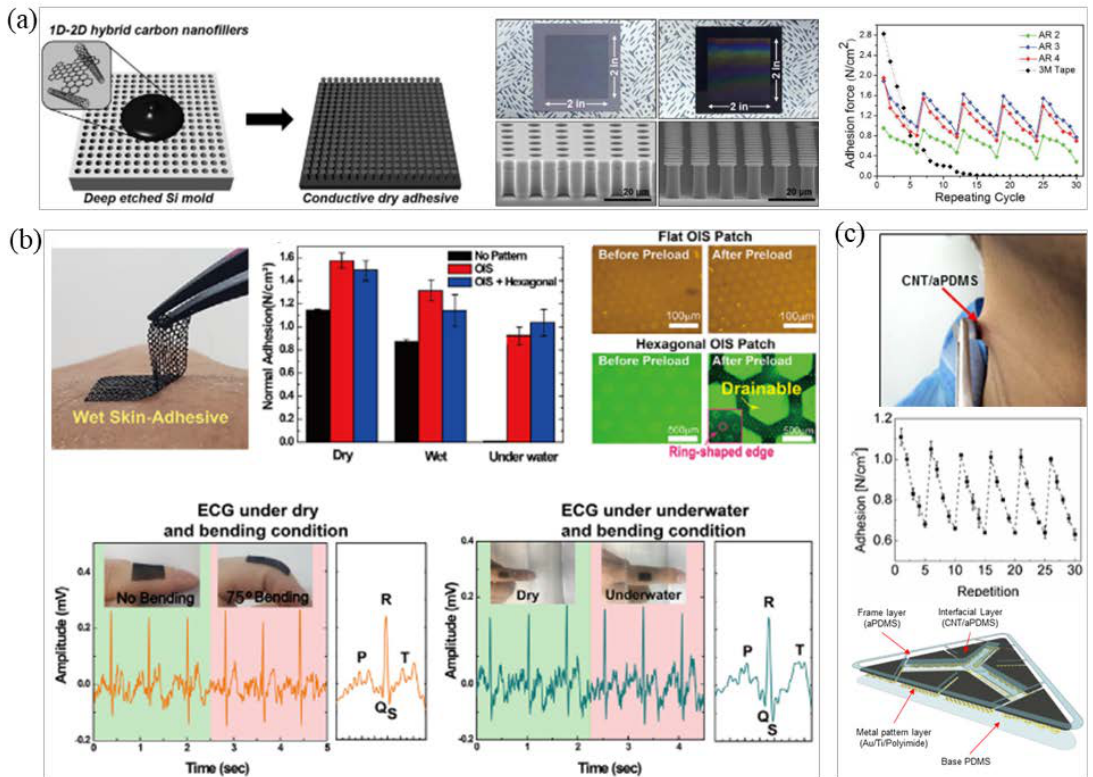
Figure 5. A summary of preparation strategies for high-adhesive electrical physiology electrodes based on bionic microstructures and conductive adhesives. ( a ) Schematic illustration of the fabrication procedure for conductive dry adhesives; digital images of a large-area silicon mold with gecko-inspired micropatterns and a replicated conductive dry adhesive; cyclic adhesion property of conductive dry adhesives compared to a commercial 3 M wet adhesive. Reproduced with permission from [119]. Copyright 2016, American Chemical Society. ( b ) Optical image of a hexagonal mesh-patterned conductive polymer composite (CPC) film with an OIS attached to human skin; normal adhesion strength for flat, OIS, and hexagonal mesh-patterned films with an OIS in dry, wet, and underwater conditions on a skin replica with a preload of 1.0 N cm − 2 ; fluorescence microscopic images representing conformal contact of a HMP OIS patch underwater; biosignals (ECG) detected by CPC stretchable electrodes attached to a human finger with 0 and 75 ◦ bending and in underwater conditions. Reproduced with permission from [28]. Copyright 2020, American Chemical Society ( c ) Adhesiveness of CNT/aPDMS, adhesion force measurements during repeated attaching and detaching processes, and structure of an ECG. Reproduced with permission from [29]. Copyright 2014, The